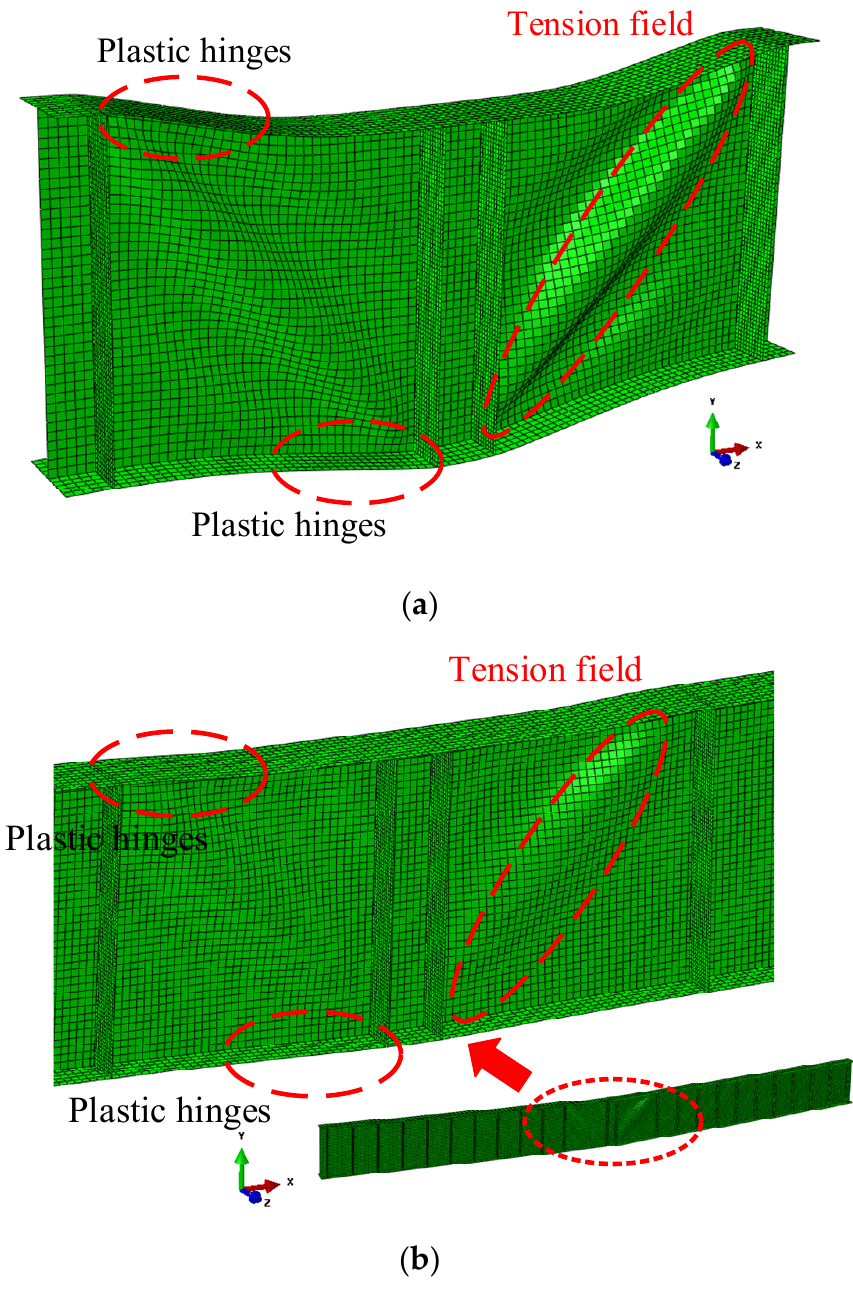
Figure 10. Failure modes of S600E s orbite SS plate girders: ( a ) P1-1-150-40; ( b ) P11-1-150-40.